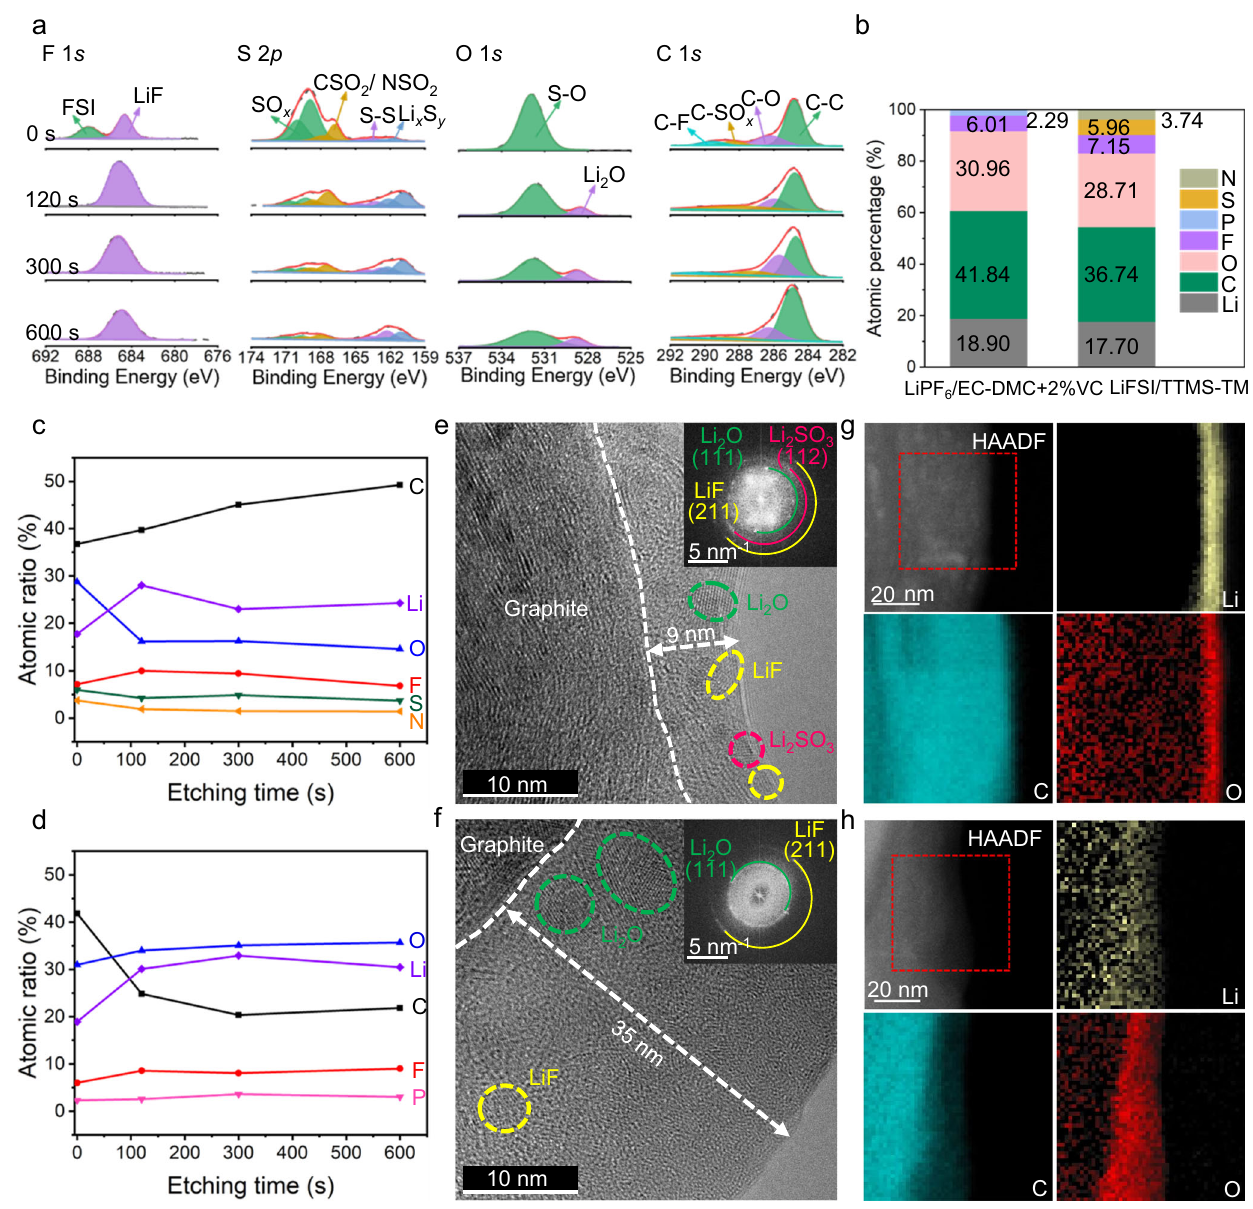
Fig. 4 | Interfacialchemistryofgraphiteanodesretrieved fromfull cellscycled with different electrolytes. a XPS depth pro fi les of F 1 s , S 2 p , O 1 s , and C 1 s for graphite anodes retrieved from full cells cycled with the 1.9M LiFSI/TTMS – TM electrolyte ata sputtering time of 0,120, 300, and 600s. b Relative content ofthe detectedelementsonthesurfaceofgraphiteanodesretrievedfromfullcellscycled with indicated electrolytes. c , d Atomic concentration at different depths of SEI